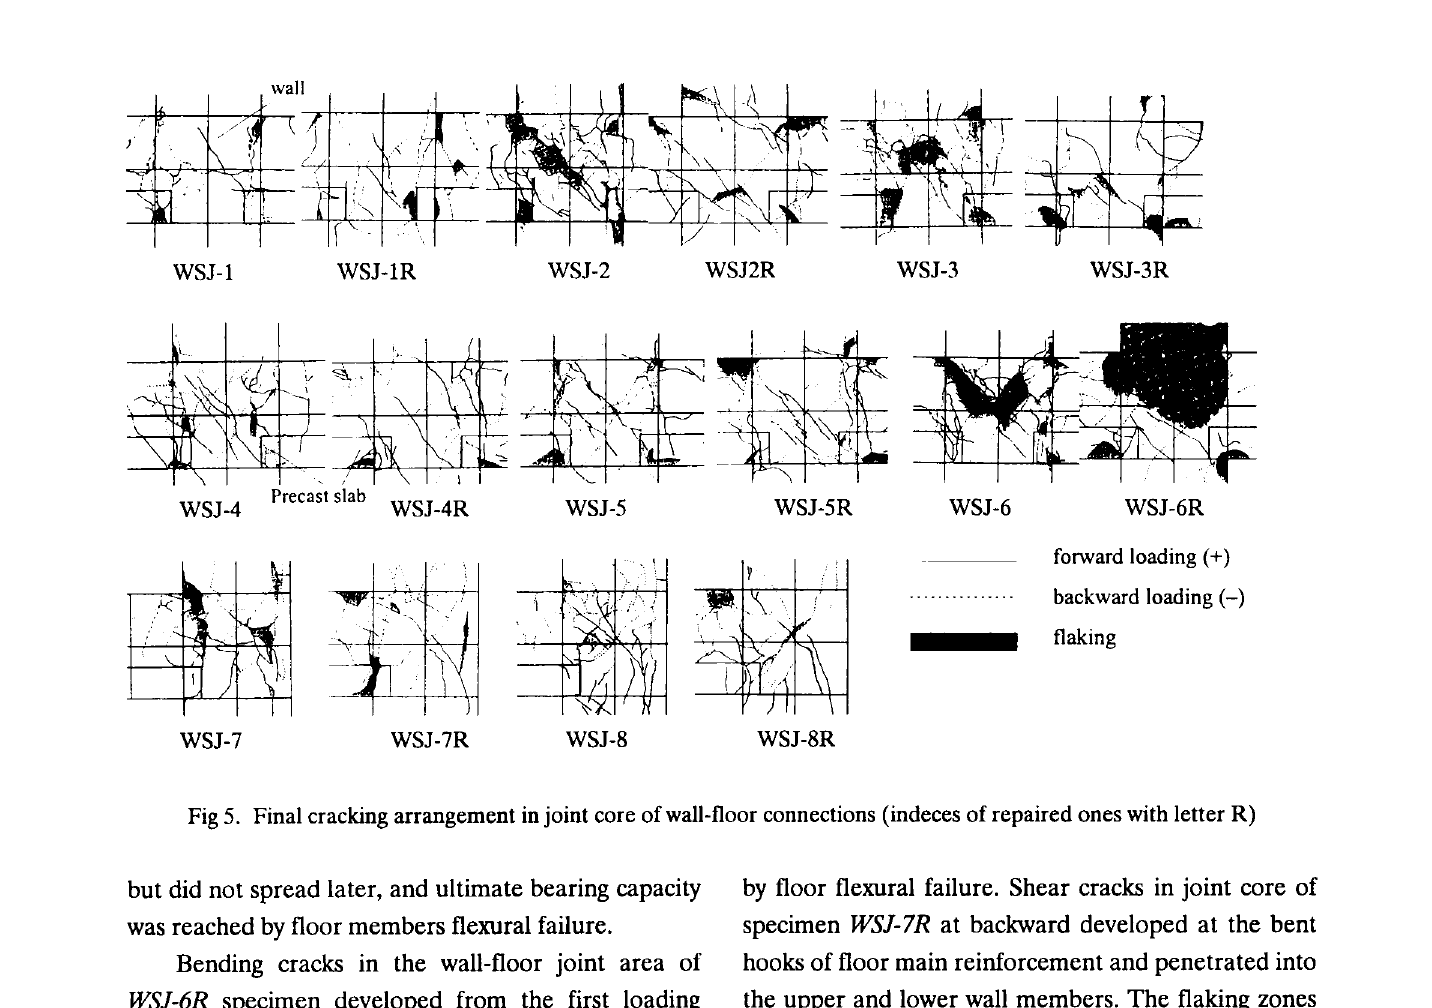
Fig 5. Final cracking arrangement in joint core of wall-floor connections ( indeces of repaired ones with letter